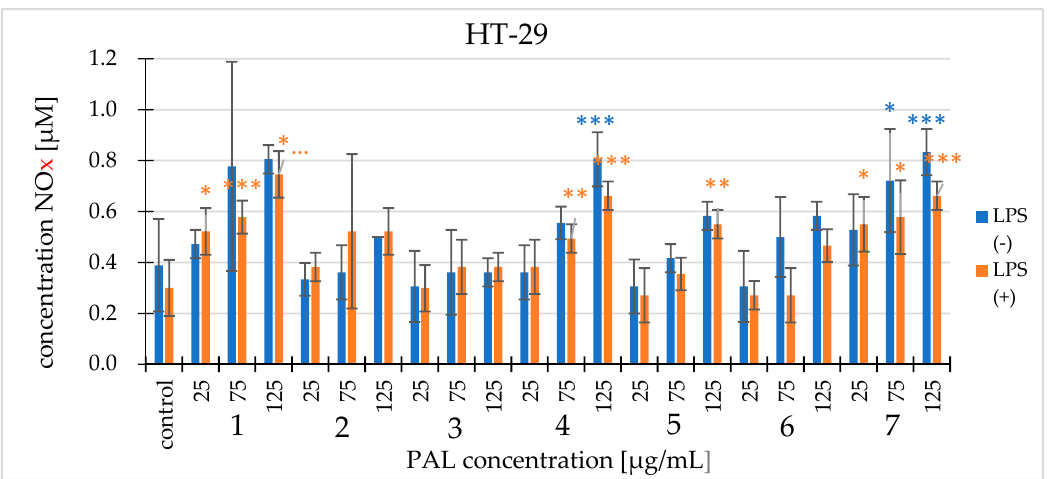
Figure 8. The e ff ect of extracts on the production of nitric oxide by the HT-29 cell line. The nitric oxide levels were tested with the addition of lipopolysaccharide (LPS) and without LPS. The values are compared to the control regarded as 100%; * p < 0.01, ** p < 0.005, *** p < 0.001, one-way ANOVA, Dunnett’s test.